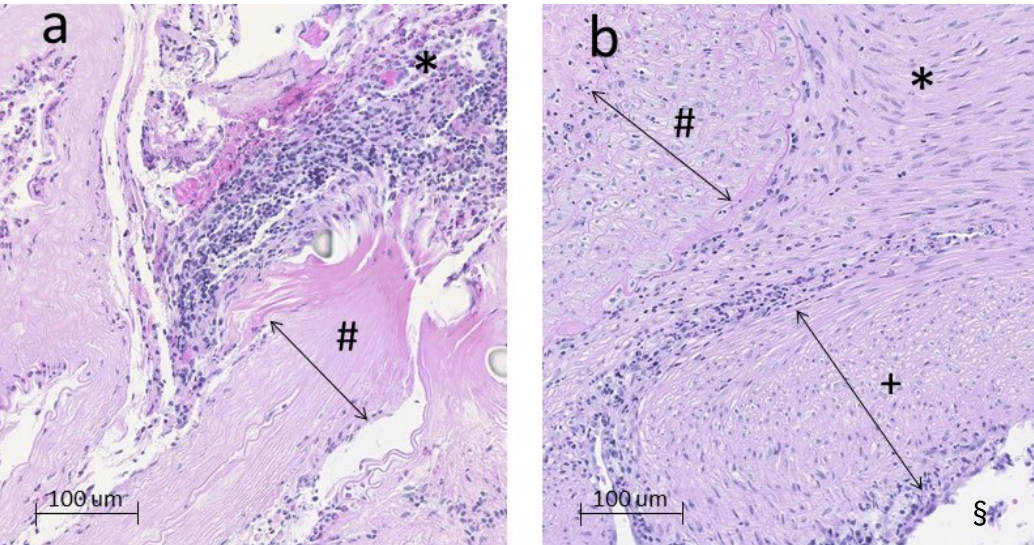
Figure 4. Exemplary histology on a 16-fold digital zoom of a decellularized ( a ) and a vital ( b ) aneurysm in sidewall constellation. The degenerated aneurysm wall (# in a) contains predominantly extracellular matrix fibres only. By contrast, the vital aneurysm wall (# in b) is marked by a high cell density. Inside the thrombus (*) of decellularized aneurysms ( a ), excessive neutrophil infiltration was observed. In ( b ), hardly any neutrophils are visible and derivates of myofibroblast have organized the former intraluminal hematoma into mature thrombus and scare tissue. Furthermore, a thick and consistent neointima ( + ) separates the former aneurysm cavity from the lumen of the parent artery (§) (similar but no visible in ( a